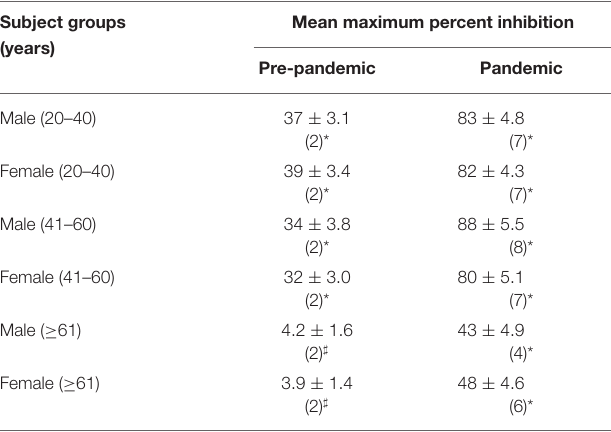
TABLE 3 | Pre- and intra-pandemic comparison of serum IgG inhibition in various age